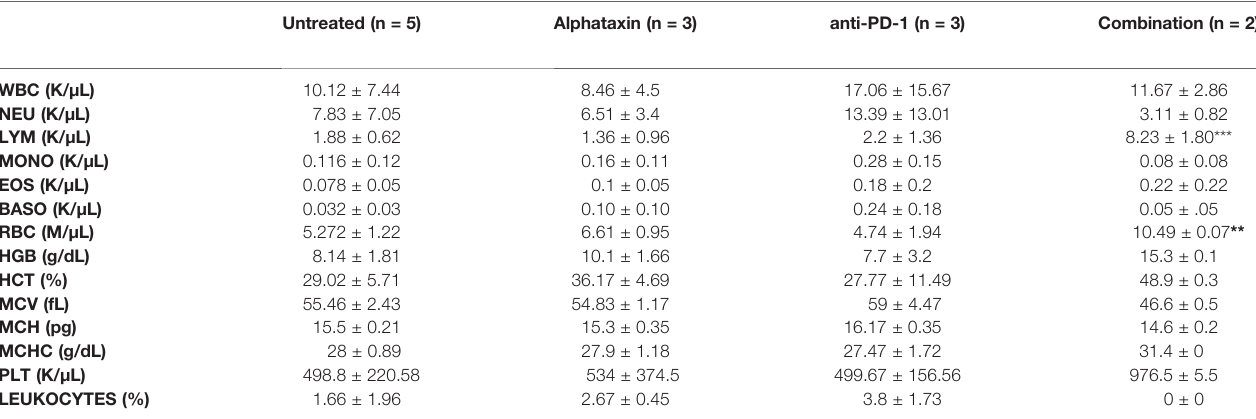
TABLE 2 | Complete Blood Count and Differential.